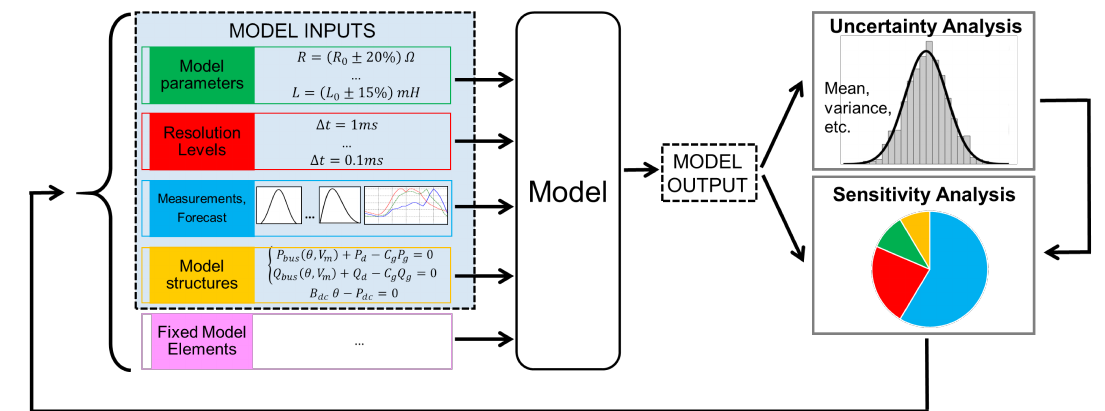
Figure 1. High-level visualization of the UA-SA framework. Note that the influence of the model elements, which are kept fixed (i.e., the assumptions excluded from the set of model inputs), cannot be explored by UA and SA, although being part of the model